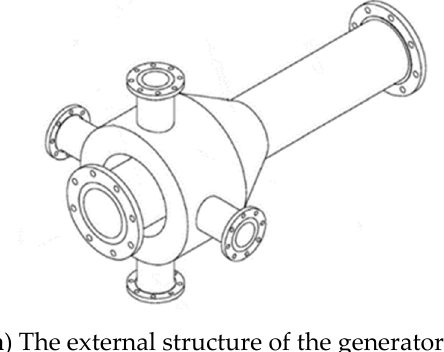
Figure 15. The structure of the generator [57].